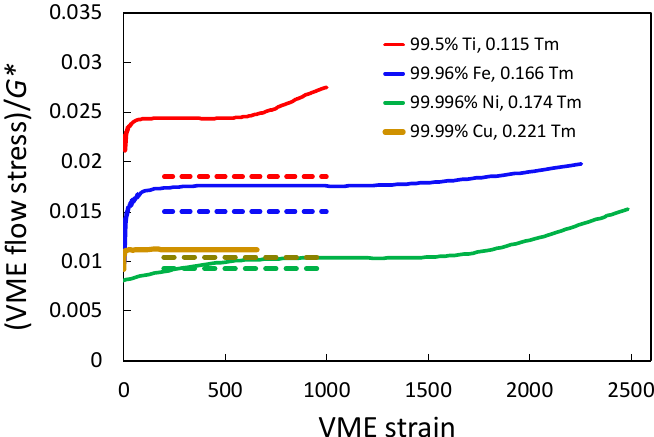
Figure 7. The stress–strain behavior of pure fcc Ni, bcc Fe, and hcp Ti ultra-deformed by torsion under (very) high pressure (HPT) (respectively 2, 6, and 2 GPa applied pressure) at room temperature beyond VME strains of 1000. The VME flow stress has been measured as HV/3, which is one-third of the Vickers microhardness. Replotted from Edalati [56]. The HPT curve of fcc Cu (6 GPa axial pressure) is from Edalati et al. [57]. Dotted lines are the average Stage IV apparent saturation flow stress of metals of similar composition deformed by ECAP in the range 8 ≤ (cid:2013)̅ ≤ 16 (Figure 6). Homologous deformation temperatures are indicated in the figure. The SFE of the four materials at RT increase in the inverse order of their homologous deformation temperature from approx. 45 mJ/m − 2 of Cu to approx. 180 mJ/m − 2 of Ti.